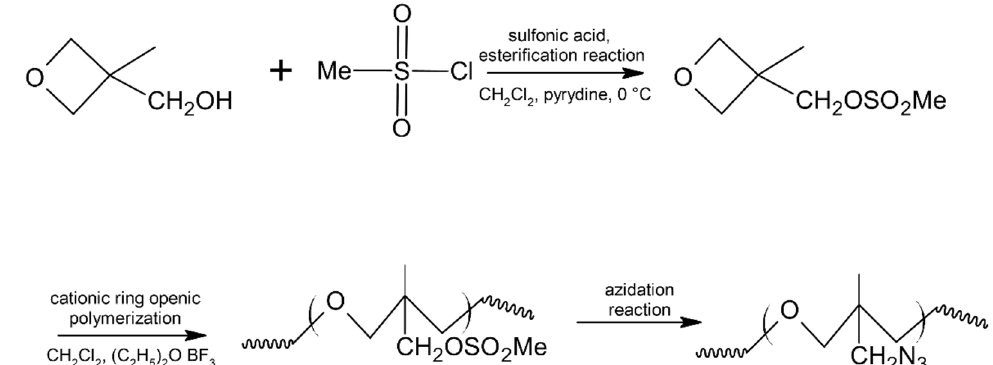
Figure 4. Synthesis of poly(3-mesyloxymethyl-3-methyl oxetane) (PAMMO). Reprinted (adapted) with permission from [38]. Copyright 2021, John Wiley and Sons.